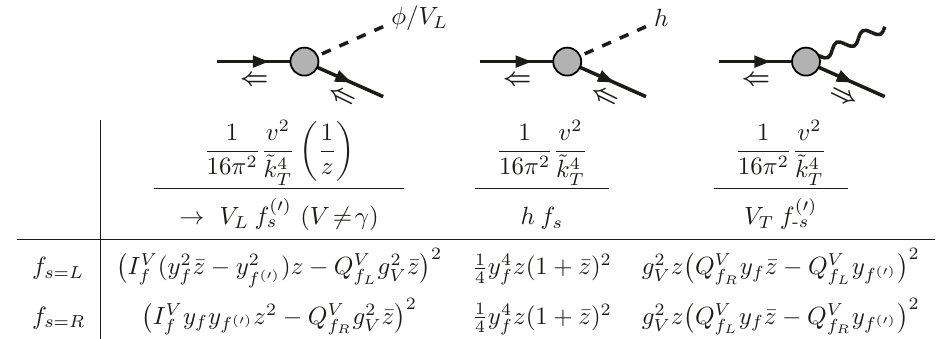
Table 4. Ultra-collinear fermion splitting functions d /dz dk 2 in the broken phase. Wavy lines T P represent transverse gauge bosons, while the longitudinals/Goldstones and Higgs bosons are repre- sented by dashed lines. The ˜ k 4 symbol is defined in eq. (4.6). The I V symbol is a shorthand for T f the “charge” of a fermion in its Yukawa coupling to the eaten Goldstone boson, or equivalently the fermion’s axial charge under the vector V . These are normalized to approximately follow the weak isospin couplings, but are defined independently of the fermion’s helicity: I Z = 1 / 2, I Z = 1 / 2, u d/e − I W ± = I W ± = 1 / √ 2. Other conventions are given in appendix u d/e